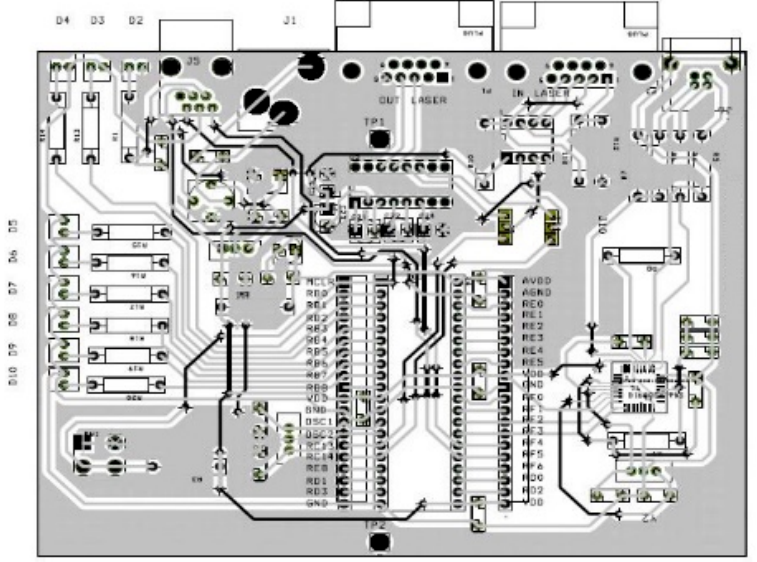
Figure 7. PCB layout.